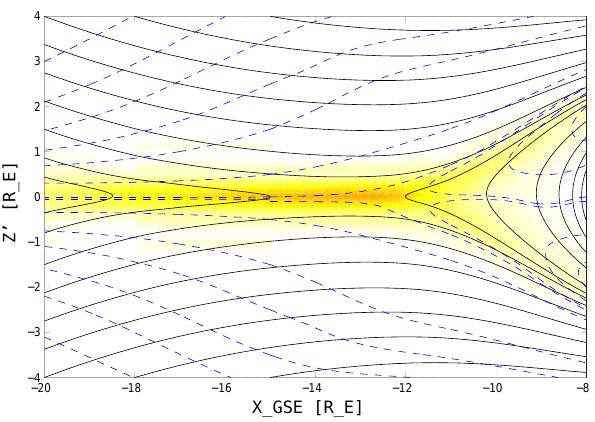
Fig. 2. Basic magnetotail reconnection geometry in two dimen- sions, on the xz plane. Colour coding depicts current density; black lines are magnetic field lines and dashed blue lines are plasma flow lines. The familiar x-point geometry of classical reconnection theo- ries can be recognized, but note the non-perpendicular inflows and the effect of the terrestrial dipole field on the